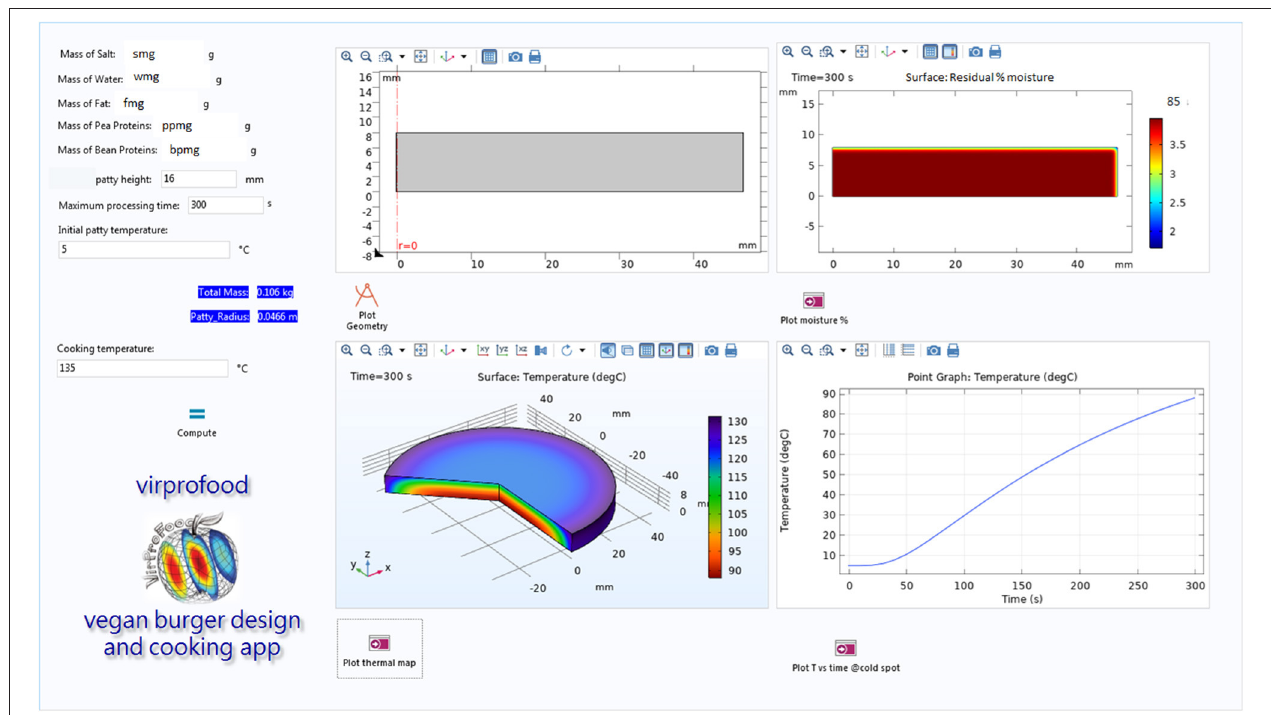
FIGURE 1 | Graphical user interface of an app for the design and the cooking simulation of plant-based burger, developed by VirProFood team at University of Salerno, Italy.